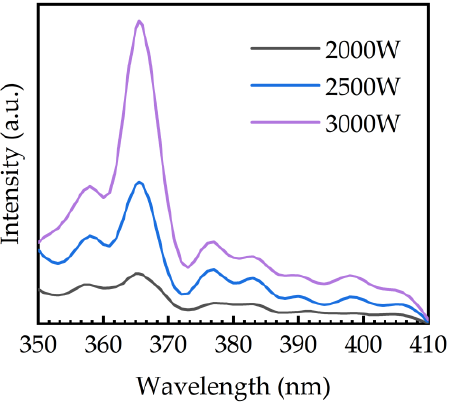
Figure 10. The PL spectra of PEALD-GaN films obtained at plasma power of 2000, 2500, and 3000 W.